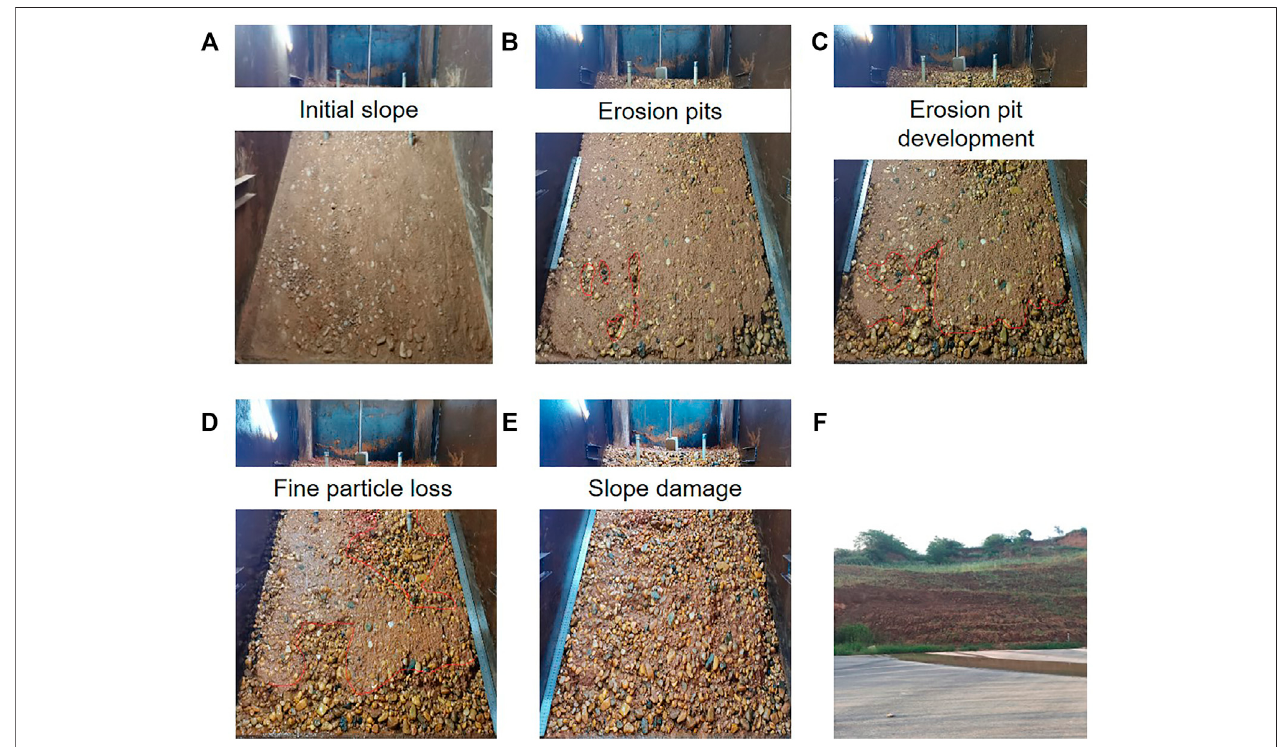
FIGURE12| Evolutionlawoferosiondamageofthetestslope(gravelcontent70%). (A) Initialslope (B )erosionpits (C) erosionpitdevelopment (D) fi neparticleloss (E) slope damage (F) actual slope failure.